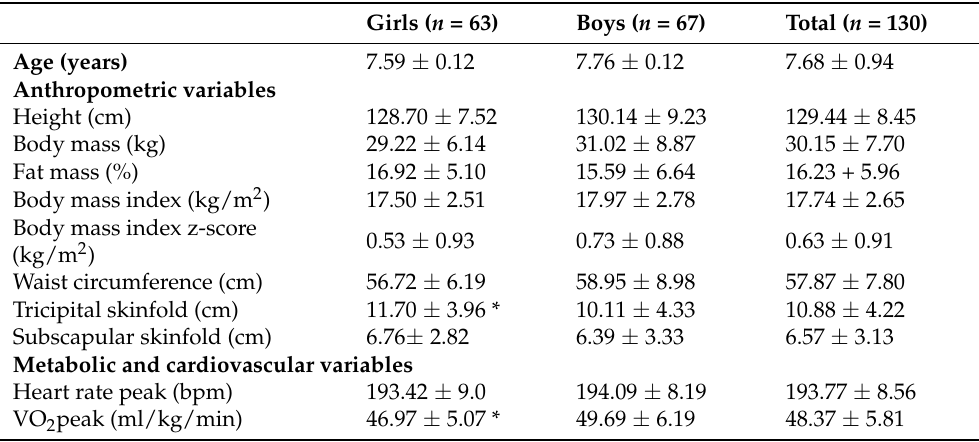
Table 2. Sample physical characteristics and metabolic, cardiovascular, and performance variables assessed during the 20mSRT (mean ±